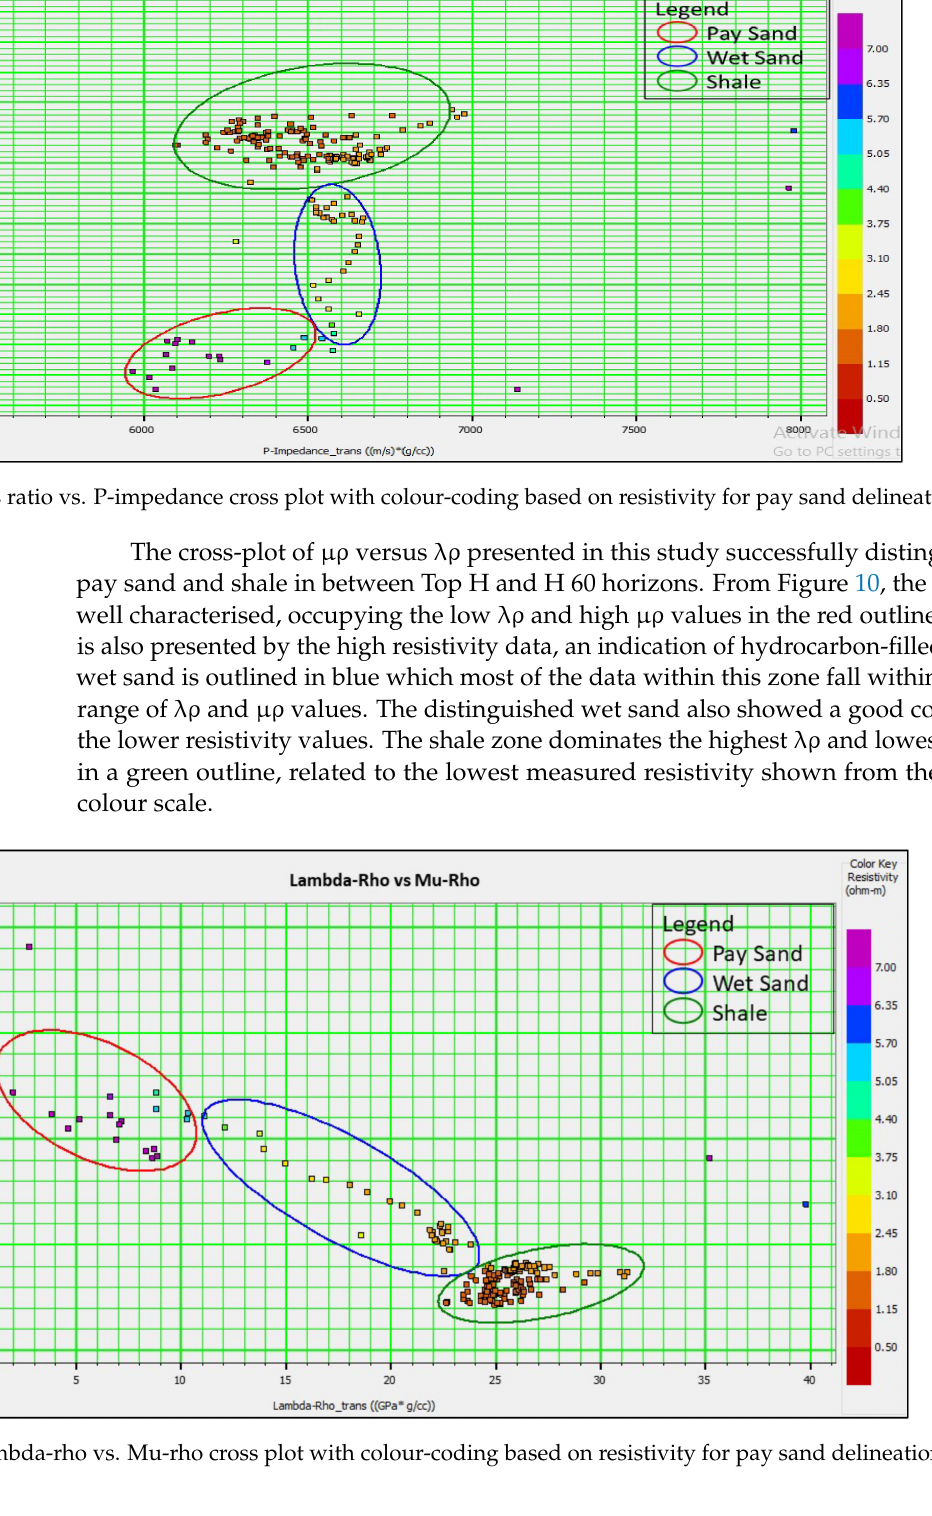
Figure 10. Lambda-rho vs. Mu-rho cross plot with colour-coding based on resistivity for pay sand